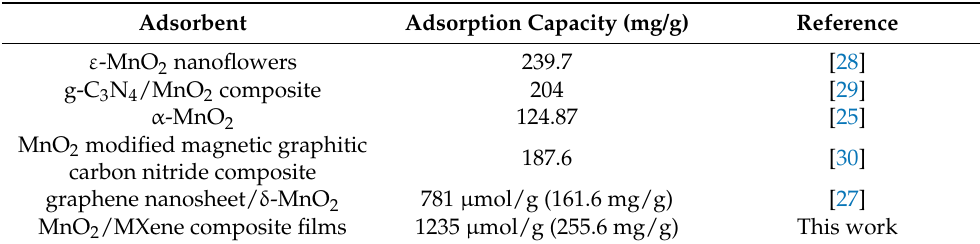
Table 2. Comparison of the maximum adsorption capacities of various MnO 2 -based adsorbents for